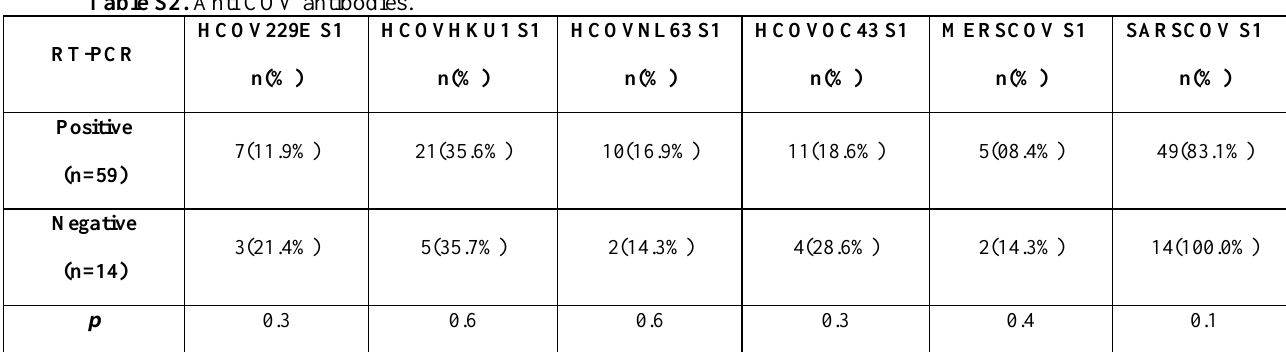
Table S2. Anti COV